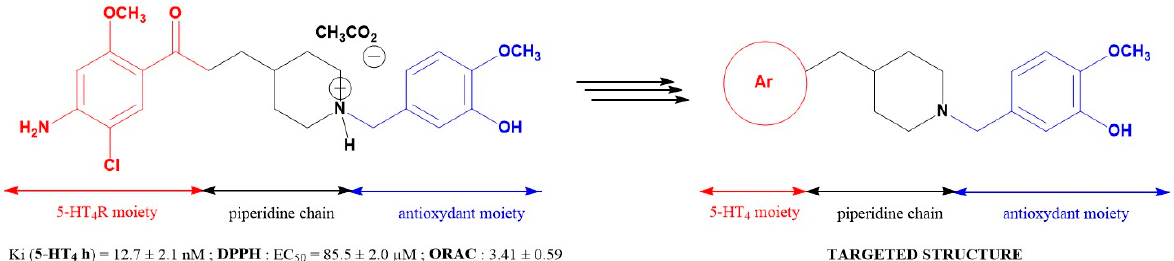
Figure 38. Structural modifications of the hit towards new